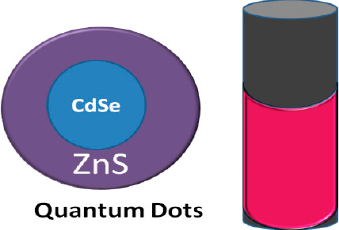
Figure 8. A semiconductor quantum and a quantum dot (QD) aqueous solution under UV light showing bright pink fluorescence. QDs are widely used in fluorescence imaging (adapted from [99]).